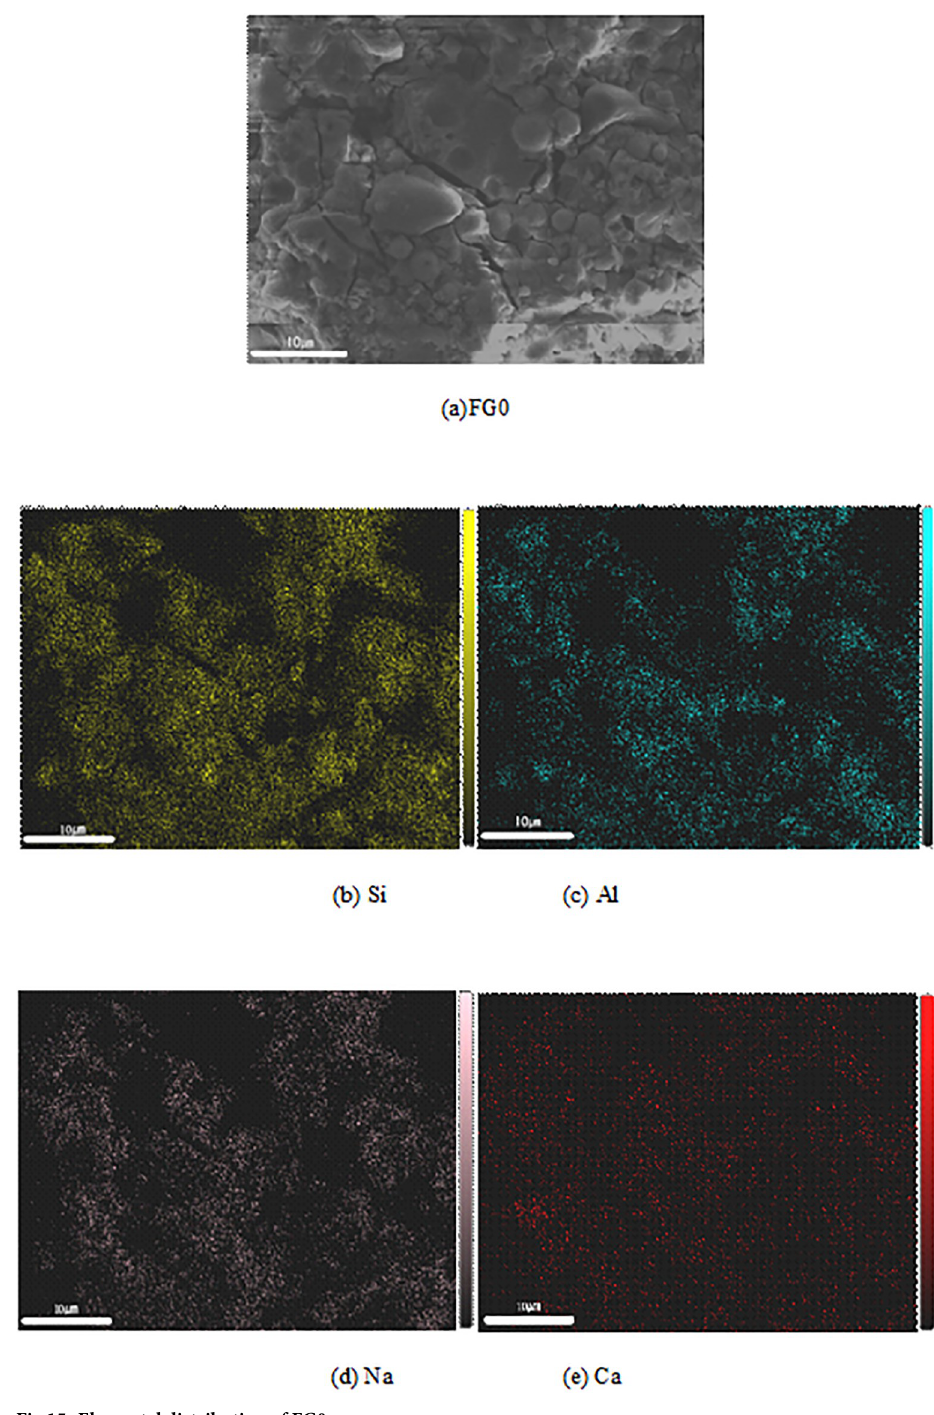
Fig 15. Elemental distribution of FG0.